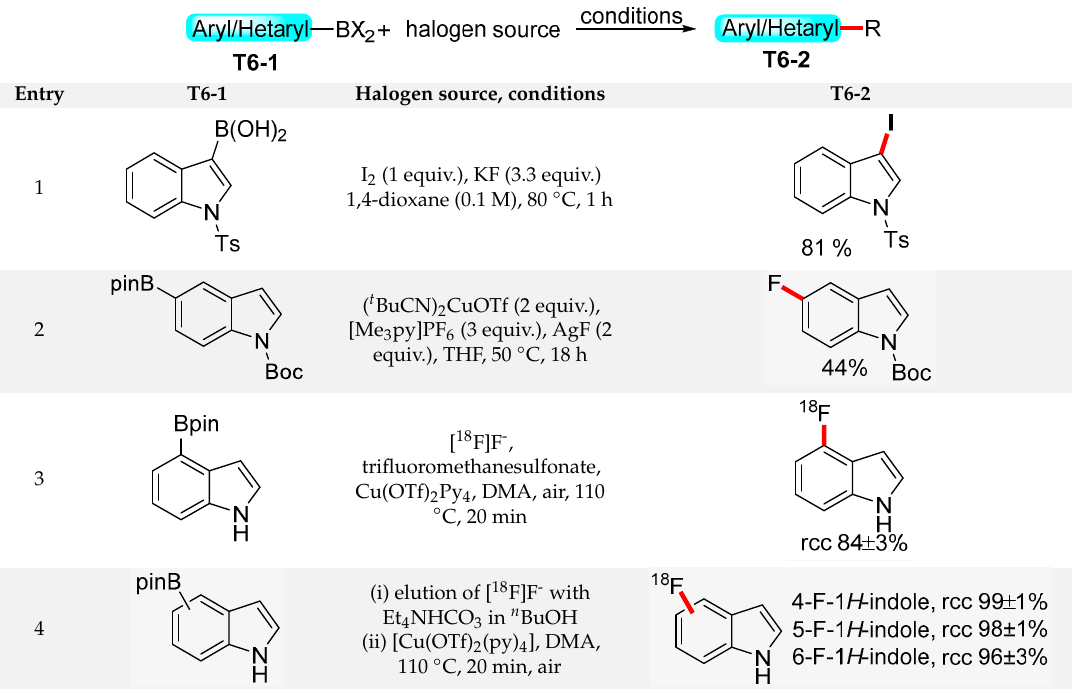
Table 6. The halogenation of indolylboronic acids.